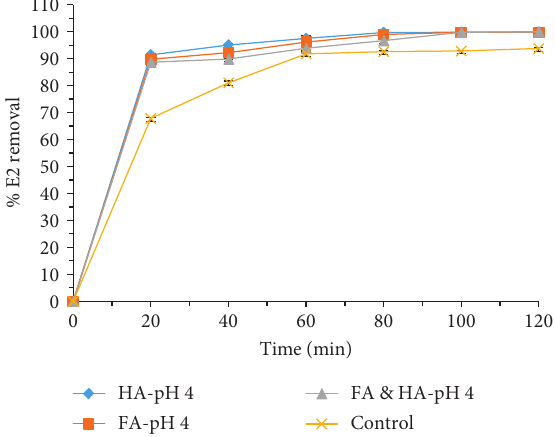
Figure 4: Removal percentage of E2 in the presence of HA, FA, and their combination for optimum